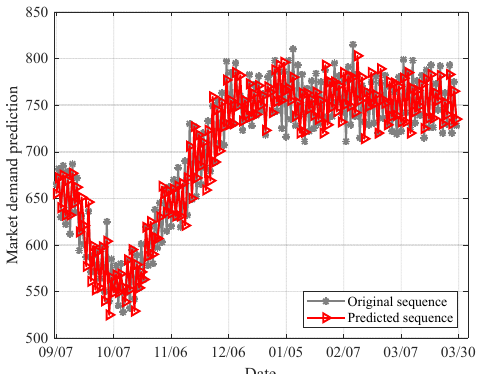
Figure 12. Performance of the proposed MHA ‐ GRU model on training dataset.